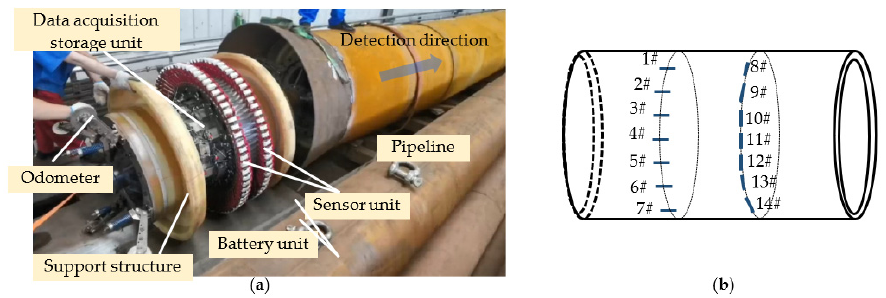
Figure 13. Sensitivity curve of the sensor.